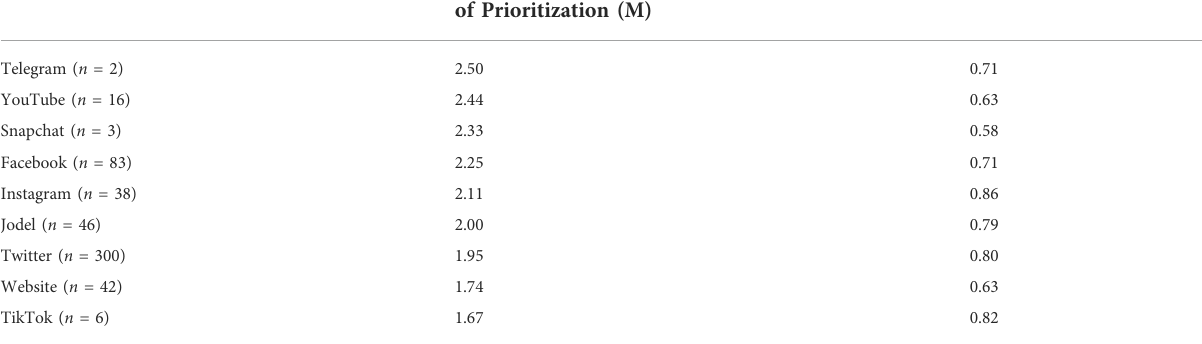
TABLE 3 Sources and prioritization.